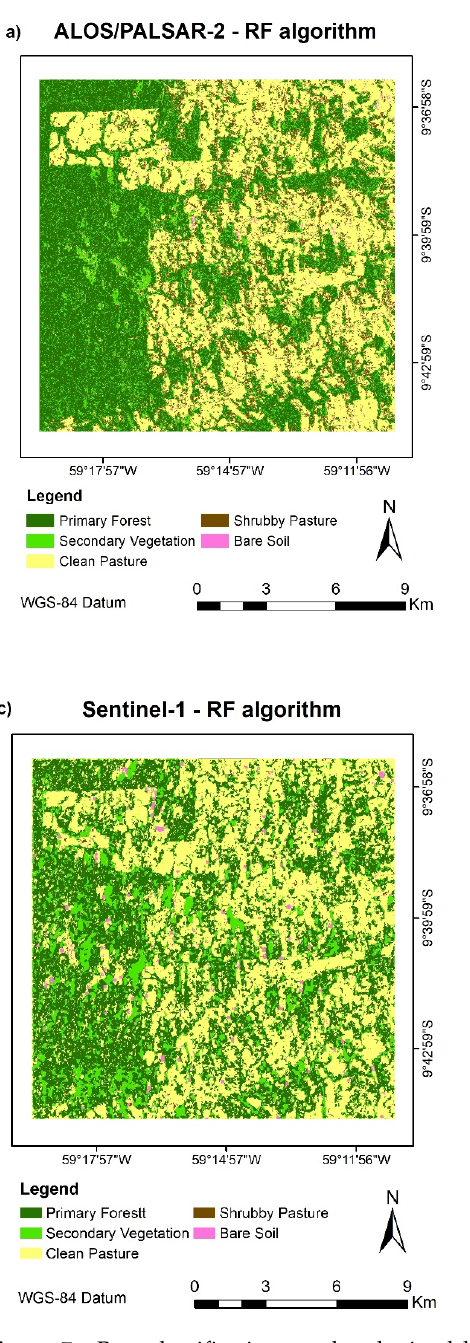
Figure 7. Best classification results obtained by the Random Forest classifier considering the ALOS/PALSAR-2 ( a ) and Sentinel-1 ( c ) data sets. ( b , d ) correspond to the ALOS/PALSAR-2 and Sentinel-1 images acquired at HV and VV polarizations, respectively, for illustration purposes.